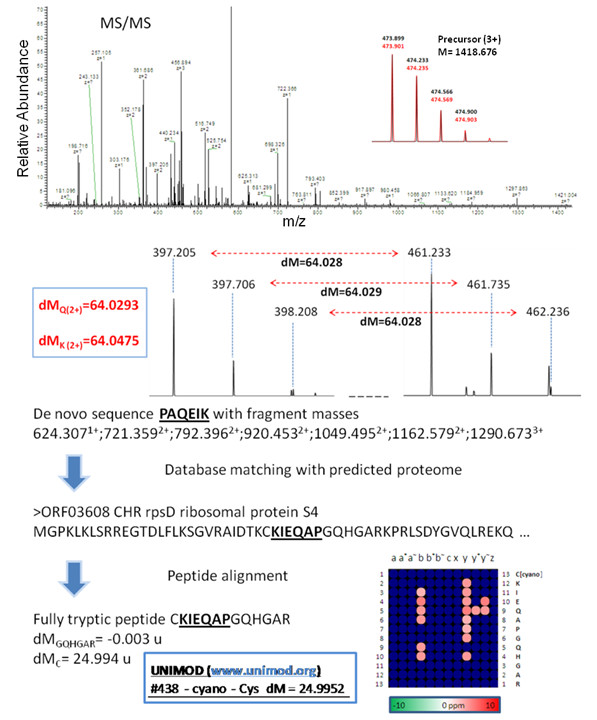
Identification of a novel PTCM in Salmonella. Cyano modification on Cys was determined for the sequence CKIEQAPGQHGAR of the Salmonella ribosomal protein S4. Explanation for the determination of modifications is detailed in text. Inset figure demonstrates how sequencing precision in high resolution MS/MS spectra easily resolves residues with close mass like Gln (Q) and Lys (K) which cannot be resolved in low resolution spectra. The map in the lower right corner of contains all predicted fragments observed from the resolved isotopic clusters with shade of spots corresponding to parts per million (ppm) distance from expected value. This map is used to determine the correct identification between all plausible sequences and PTCMs matching observed mass shifts.